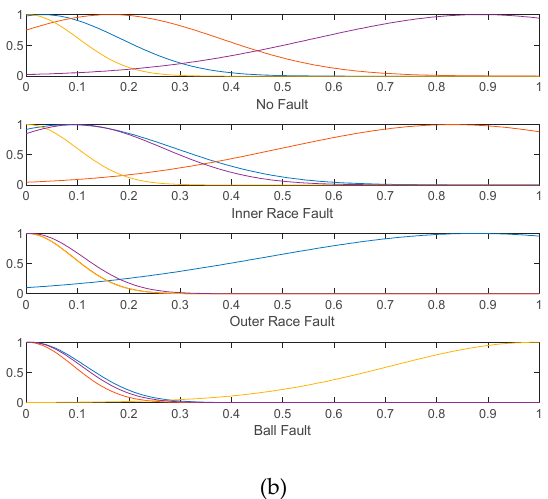
Figure 10. Proposed Fuzzy inferencing system for bearing fault classification: ( a ) Input ‐ Output model of the proposed fuzzy inferencing system; ( b ) membership functions for output classes of bearing condition.